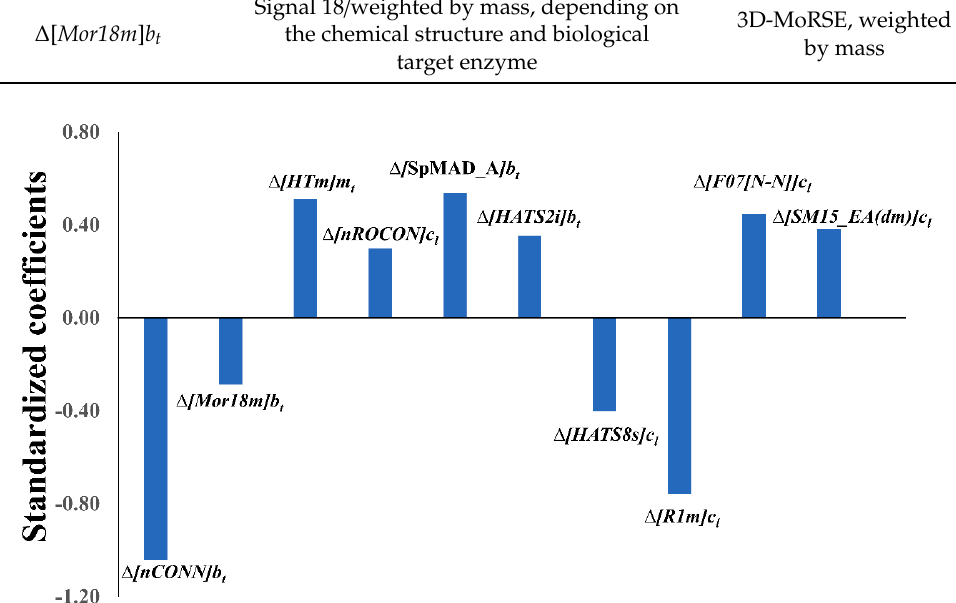
Figure 2. Standardised coefficients vs. variables in the mt-QSAR LDA model.